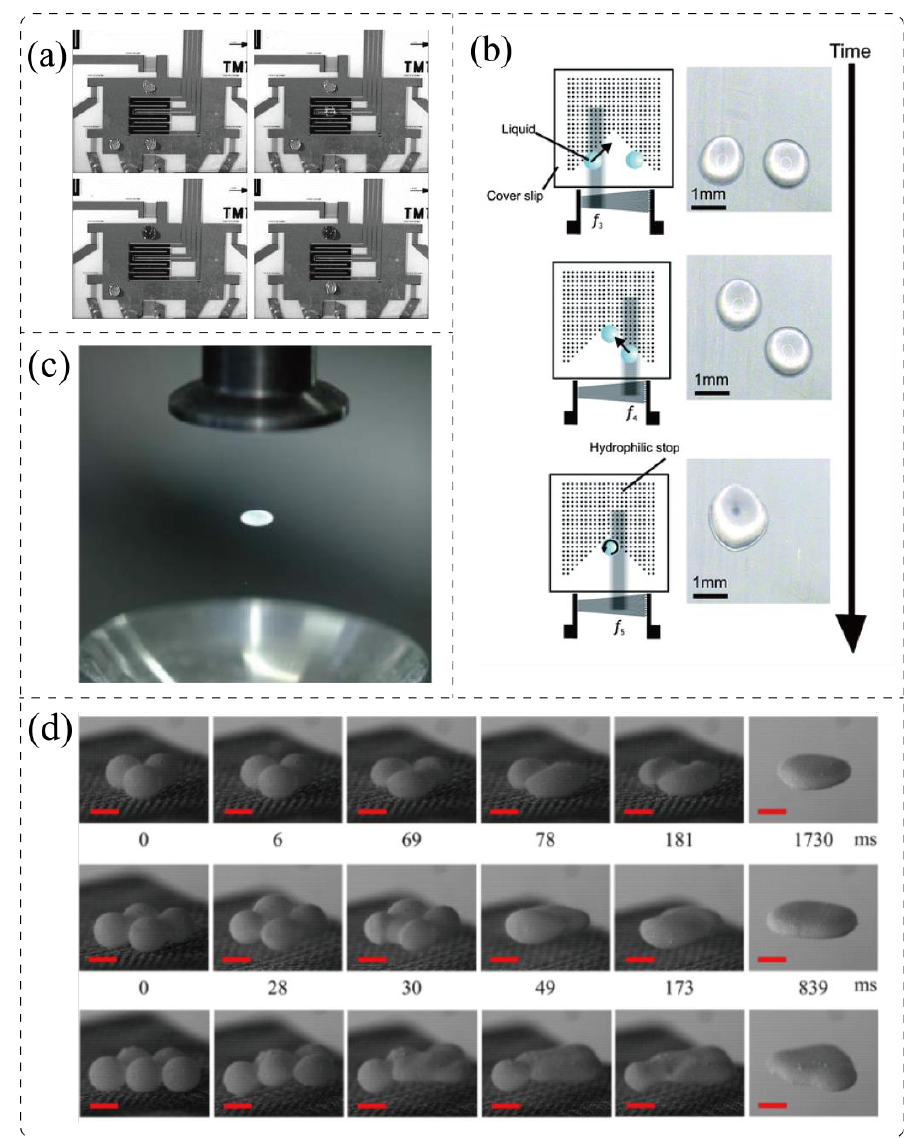
Figure 10. ( a ) Snapshots of droplets moving along a pre-designed track for merging under the action of surface waves [102] (Reproduced with permission from Springer Nature, 2004). ( b ) Two droplets with different orientations merge at specific positions under the asymmetric action of surface acoustic waves [124] (Reproduced with permission from Royal Society of Chemistry, 2010). ( c ) An LM is levitated by sound waves [126] (Reproduced with permission from American Chemical Society, 2015). ( d ) The levitation and coalescence of multiple LMs in a sound levitator (scale bar: 2 mm) [127] (Reproduced with permission from American Chemical Society, 2017).